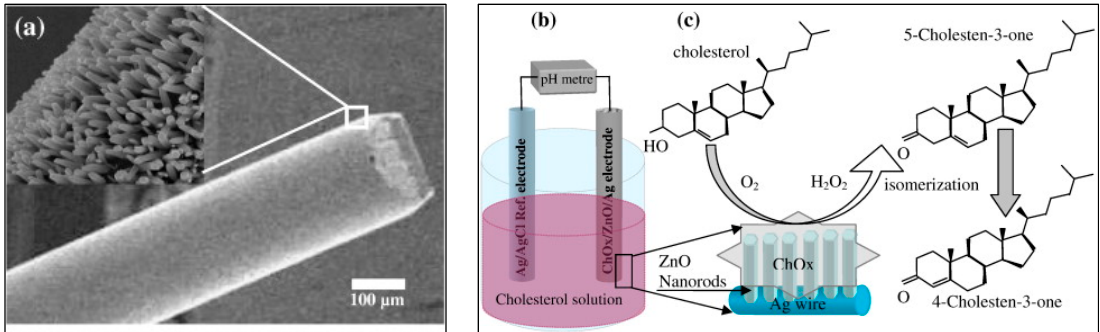
Figure 2. ( a ) SEM image of ZnO nanowires chemically grown on a silver wire. ( b , c ) Experimental setup and reaction mechanism of the cholesterol detection process [23].